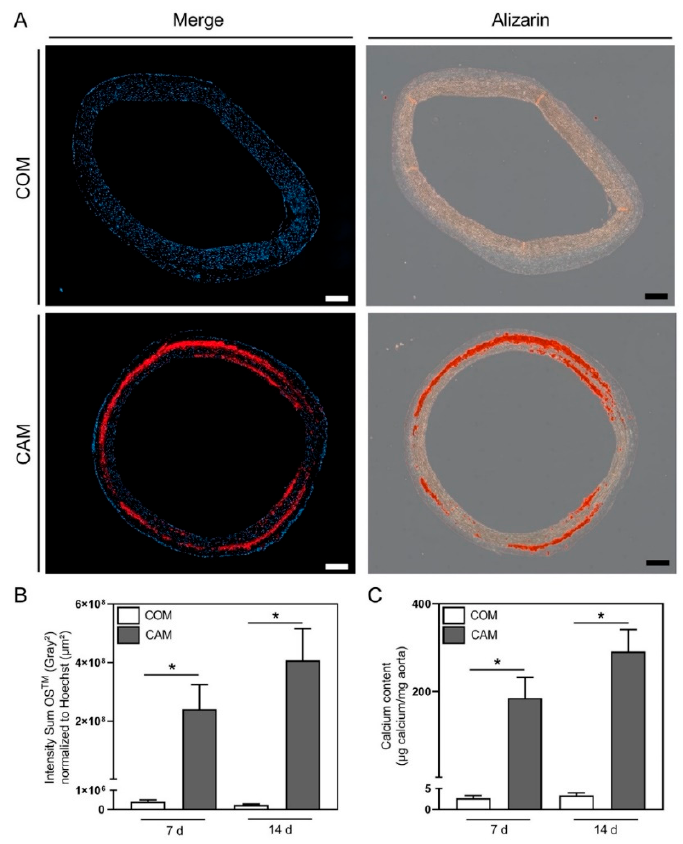
Figure 2. Hydroxyapatite and calcium staining in aortic tissue slides. ( A ) Representative images of aortic staining for hydroxyapatite with OsteoSense™680EX (OS TM ) (red channel) and cell cores with Hoechst33432 (blue channel) or Alizarin Red upon stimulation with control medium (COM) or calcification medium (CAM), respectively, for 7 d. ( B ) Quantification of the fluorescence signal of OS TM upon stimulation with COM or CAM, respectively, for 7 and 14 d. ( C ) Photometric quantification of aortic calcium amount upon decalcification in hydrochloric acid upon stimulation with COM or CAM, respectively, for 7 and 14 d. The scale bar indicates a 200 µm section, n ≥ 3, mean ± SEM, * p < 0.05 compared to marked control.